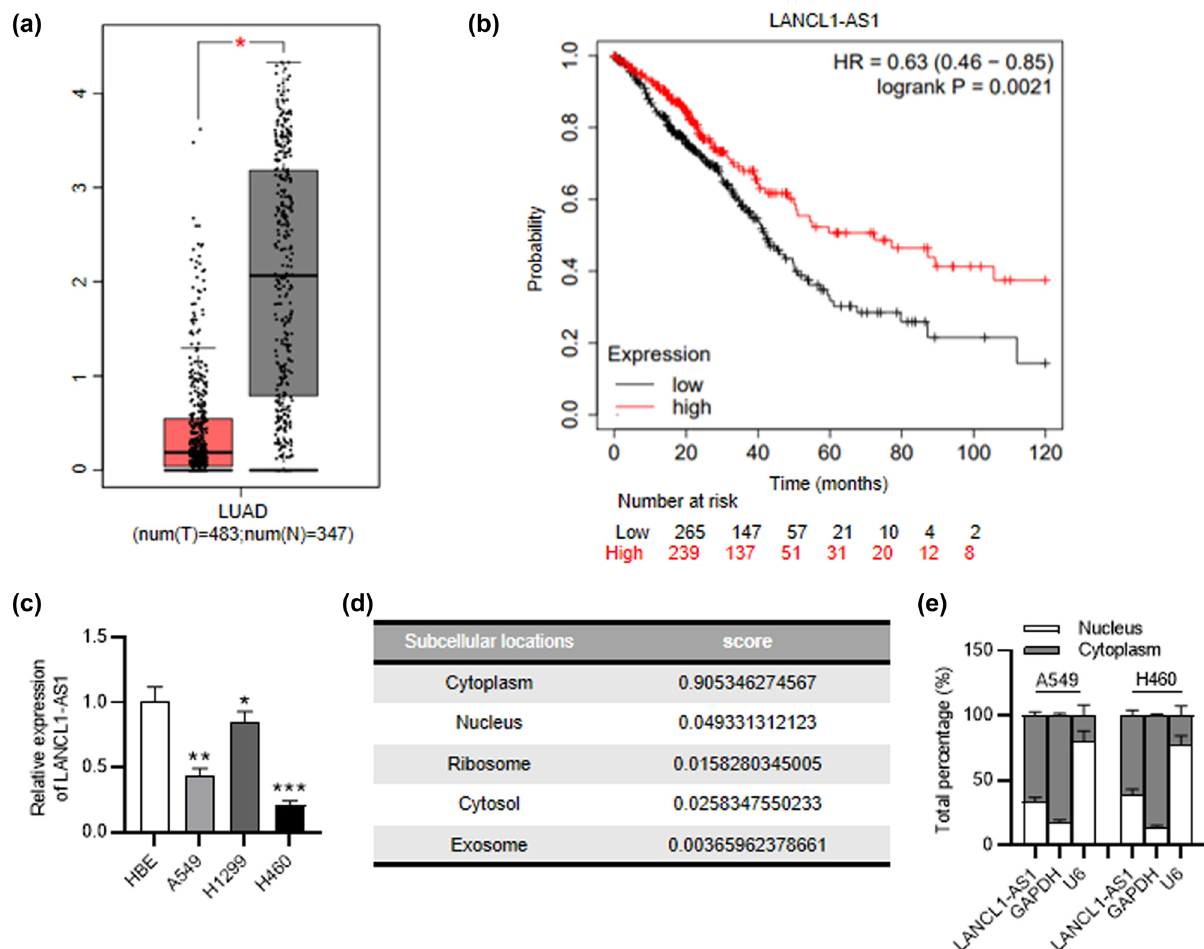
Figure 1: LANCL1 - AS1 is downregulated in NSCLC. ( a ) LANCL1 - AS1 expression in LUAD ( n = 483 ) and normal tissues ( n = 347 ) displayed by GEPIA database. ( b ) The relationship between LANCL1 - AS1 expression and LUAD patient prognoses shown by Kaplan – Meier plotter website. ( c ) RT - qPCR analysis of LANCL1 - AS1 level in NSCLC and normal cell lines. ( d ) The location of LANCL1 - AS1 in cells predicted by lncLocator website. ( e ) Subcellular fractionation assay of LANCL1 - AS1 location in NSCLC cells. * p < 0.05, ** p < 0.01, *** p <